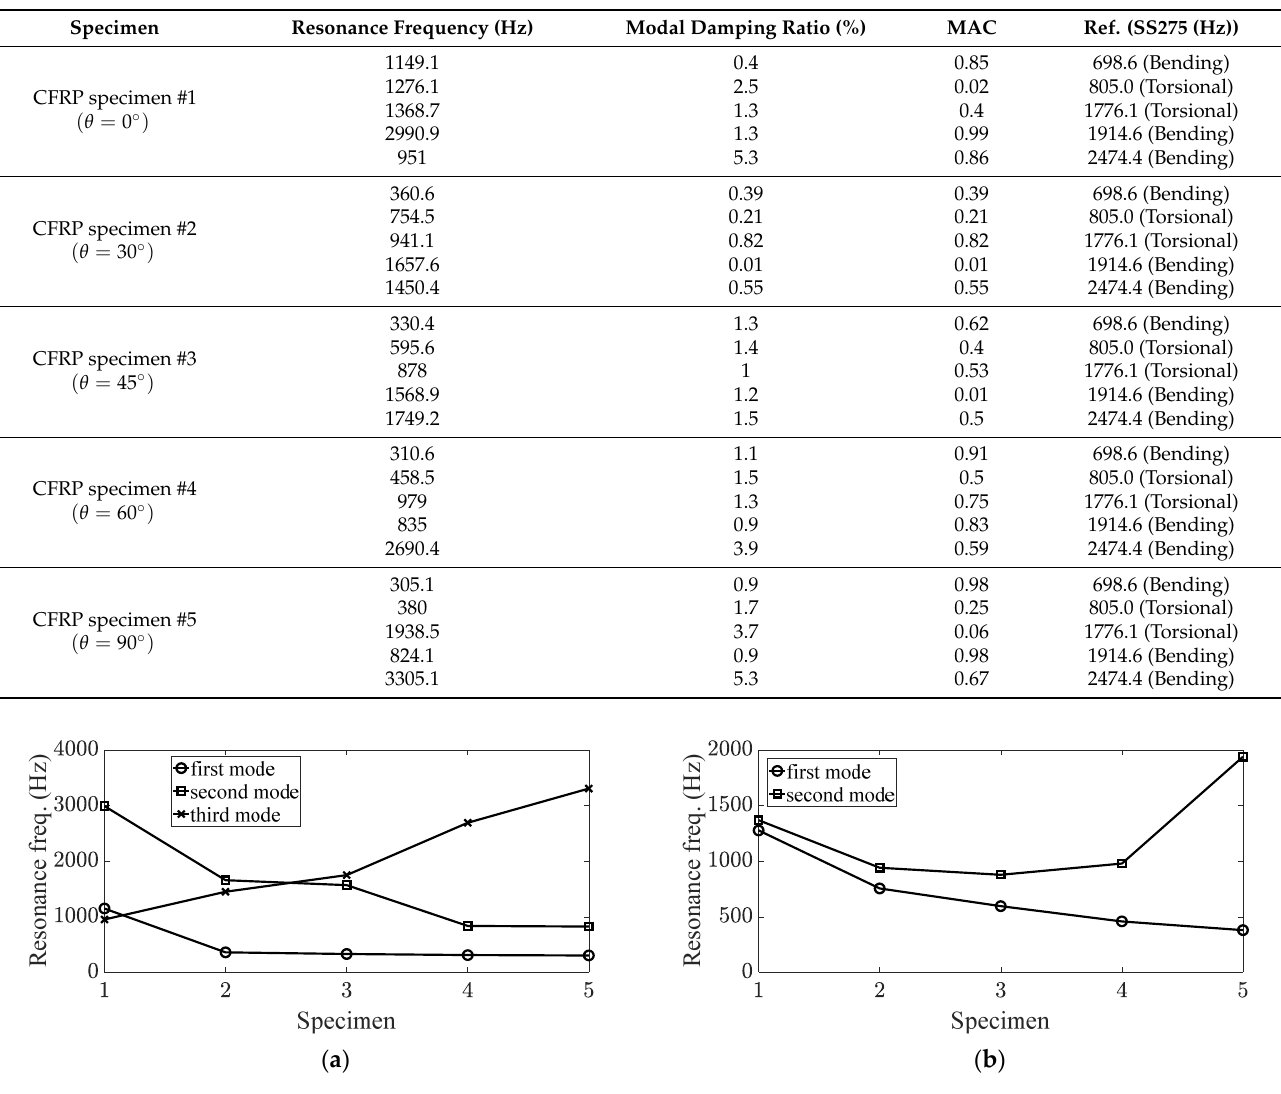
Table 3. Comparison between the CFRP and SS275 specimens.